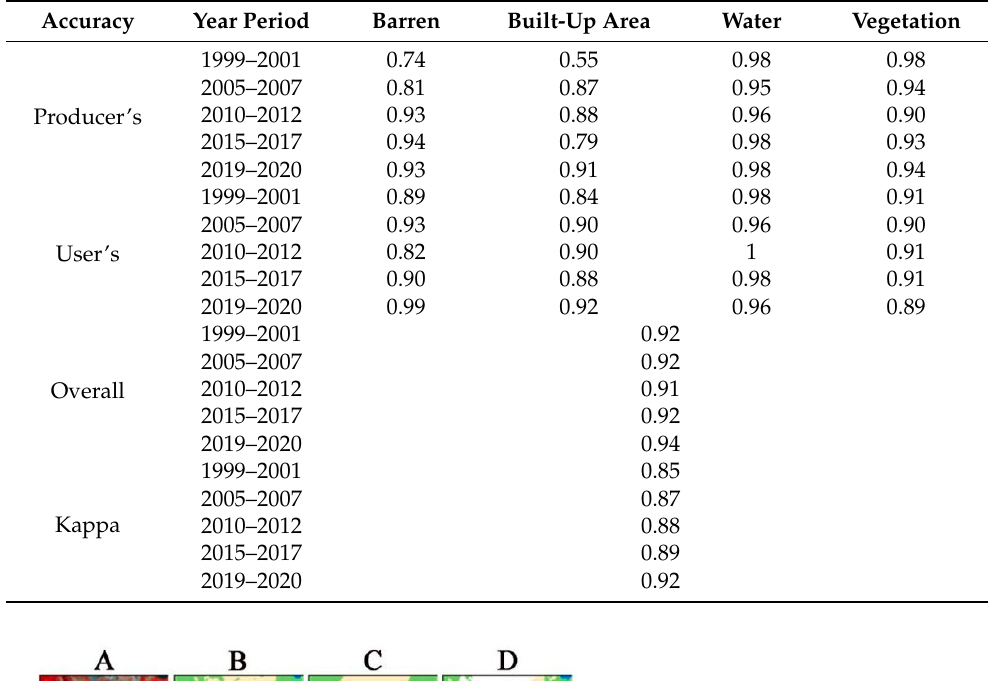
Table 4. Accuracy evaluation of land cover classification results in the five periods: 1999–2001,